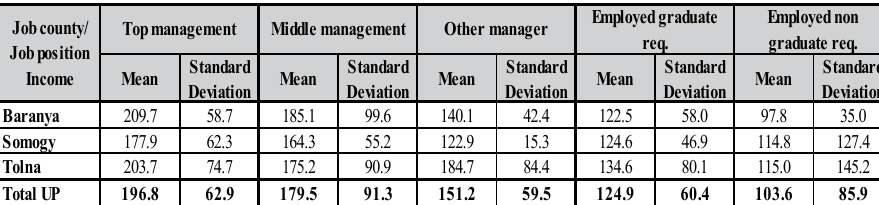
Table 4. The graduates’ net income (in thousands of HUF) by the job position in the South-Transdanubian region